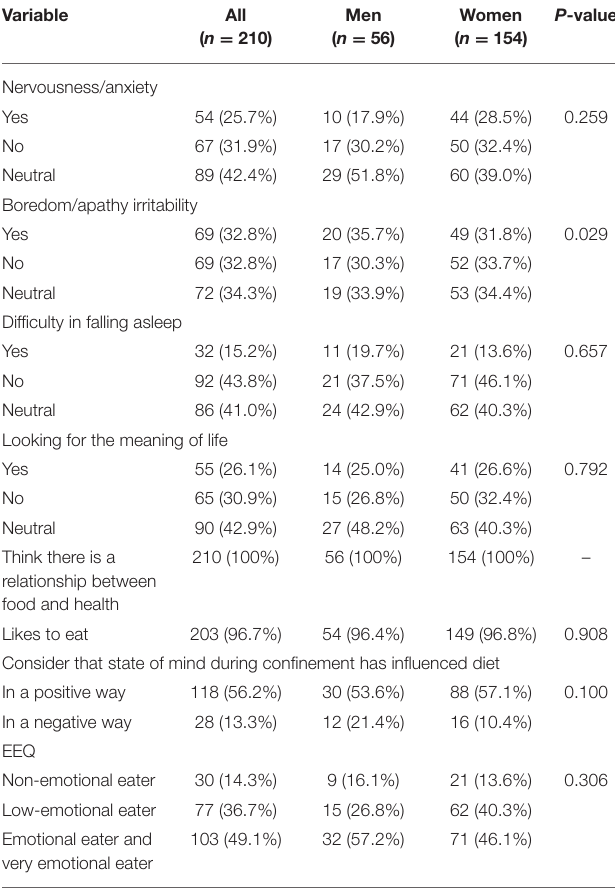
TABLE 3 | Changes in emotional states during